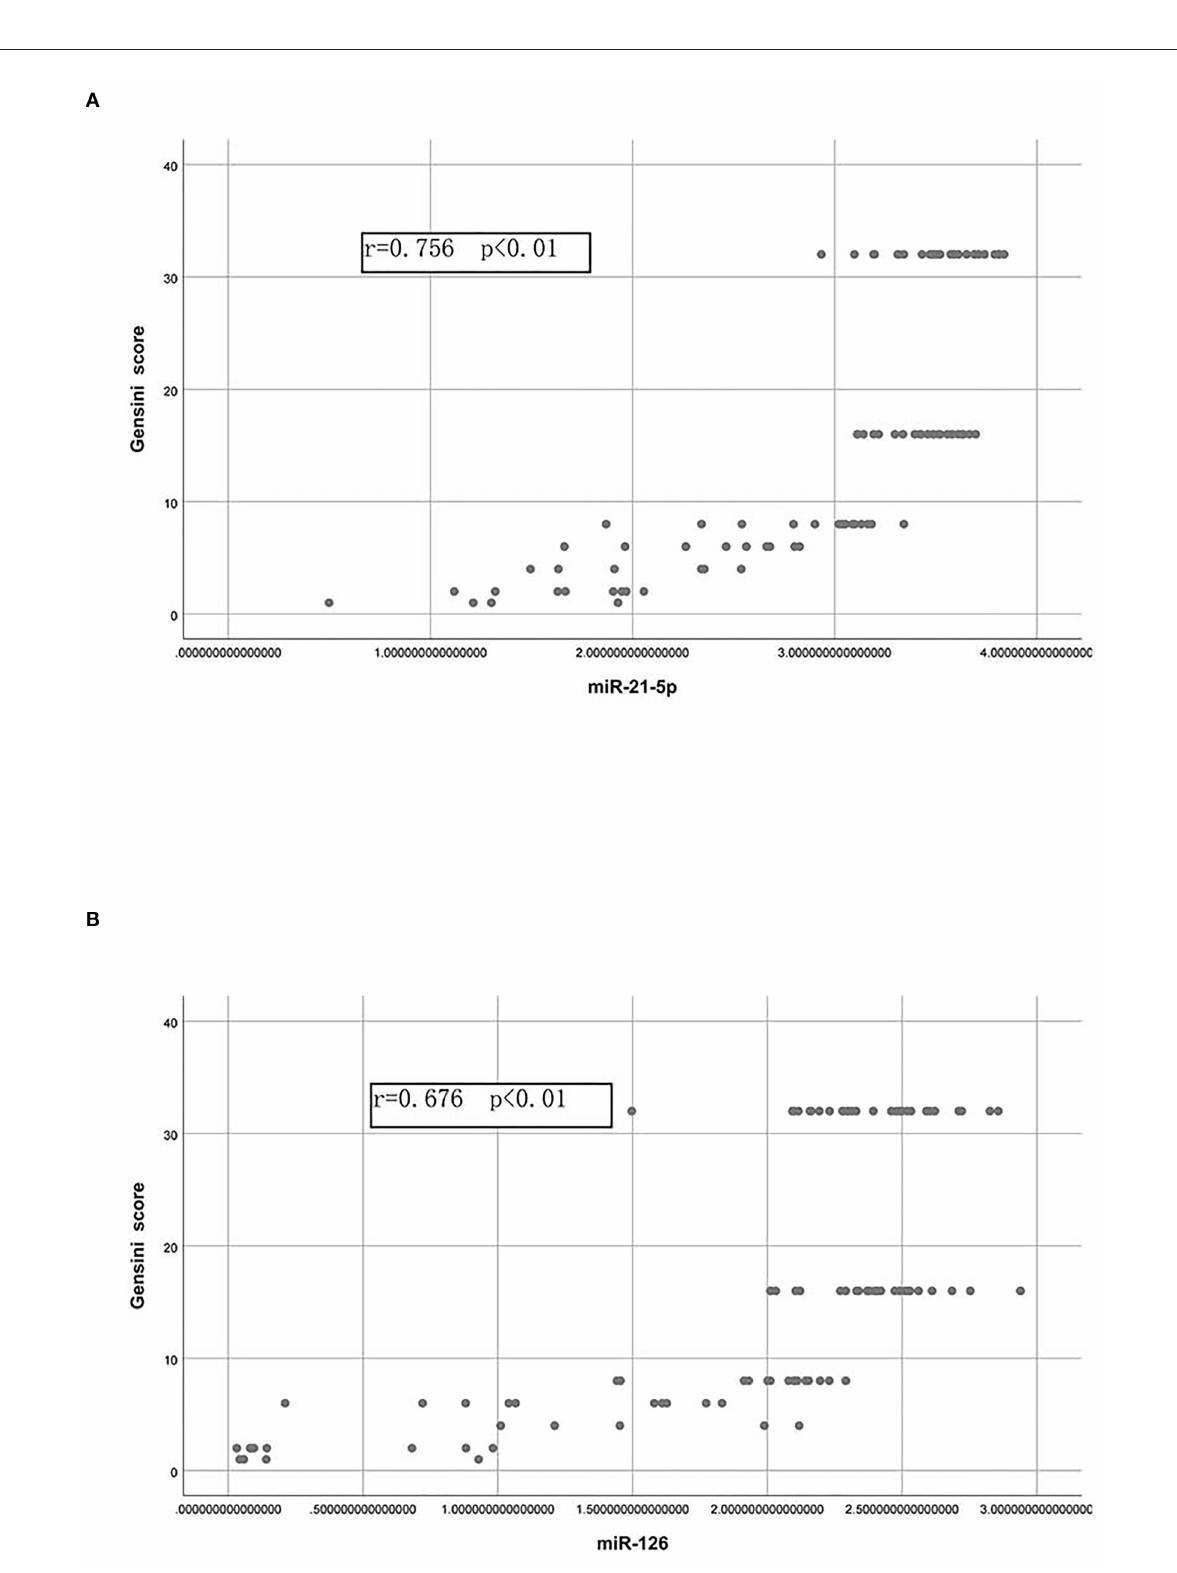
FIGURE3 Correlations of the Gensini score with the plasma levels of miR-21-5p and miR-126. (A) Pearson correlation between the Gensini score and the levels of miR-21-5p. (B) Pearson correlation between the Gensini score and the levels of